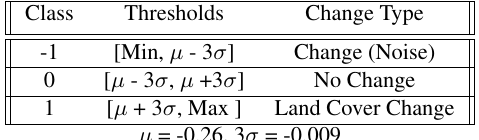
Figure 2: [Top Row] uses the near-infrared (NIR) band from February and April NIR (RGB(Feb NIR, Apr NIR, Apr NIR) to generate a change detection map showing new construction. [Bottom Row] uses NDVI from February and April in RGB mem- ory banks RBG(Feb NDVI, Apr NDVI, Apr NDVI) to show dis- turbances in vegetation.